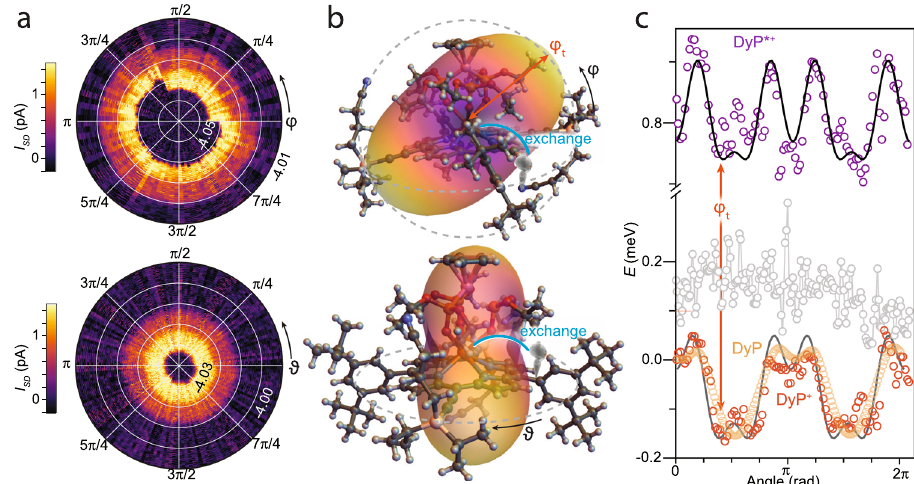
Fig. 6 Angular relation to single-ion anisotropy. a Measured angular evolution of the exchange effect, showing the current (color scale) vs. V G (radial) and the angle (top: out-of-plane φ ; bottom: in-plane θ ), under constant magnetic fi eld-magnitude | B | = 1 T, at V SD = 1.5 mV. A charge jump is observed for 0 < φ < 2 π /3). b Iso-energy representation of the single-ion anisotropy of the Dy(III) ion, superimposed onto the molecular structure, as viewed from sideways in the single-molecule device architecture (top) and along the electron transport channel (bottom). c Angular evolution of the energy, relative to the ground state at zero angle, of the DyP + * (violet) and DyP + (orange) states vs. φ , with the anisotropy energy extracted from torque measurements on the DyP at the same temperature superimposed (yellow). The lack of evolution vs. θ is also shown (gray). Black lines are fi ts to the data (see text). All data were acquired at 20